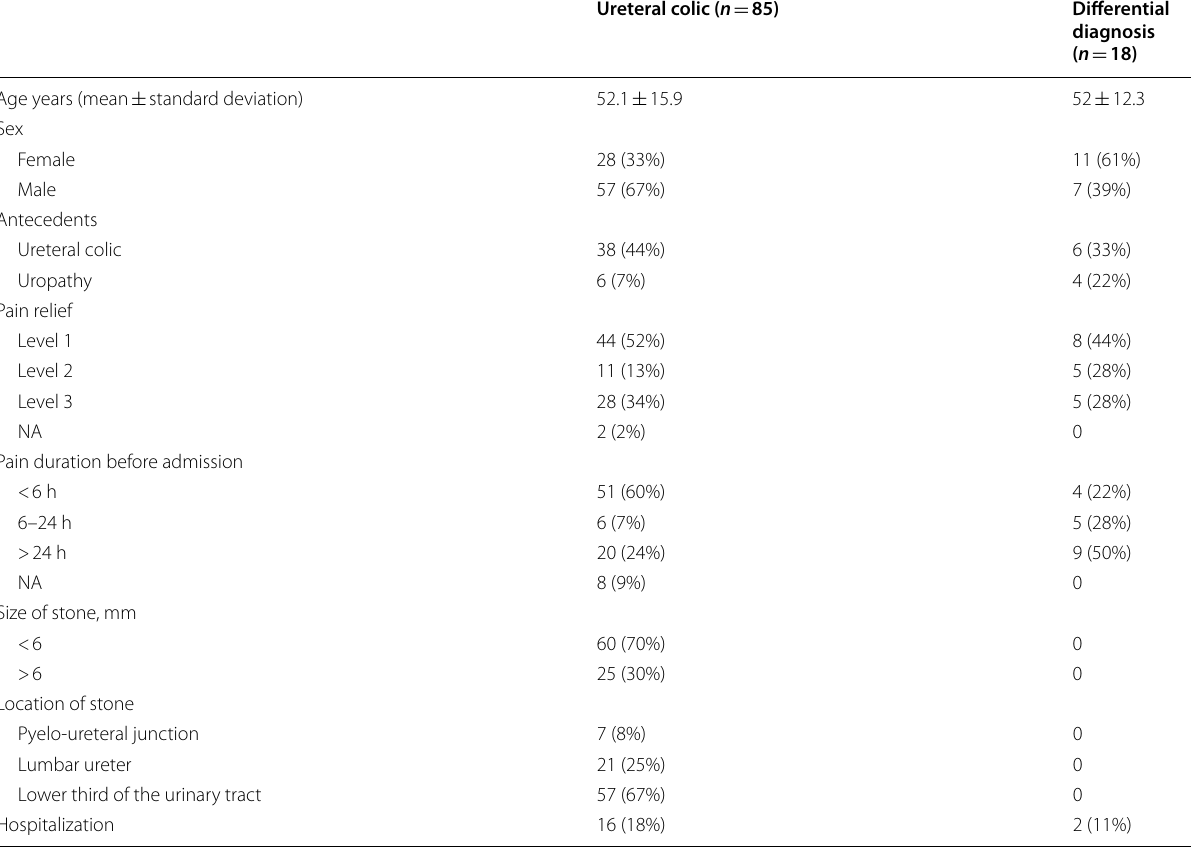
Table 1 Characteristics of patients with confirmed ureteral